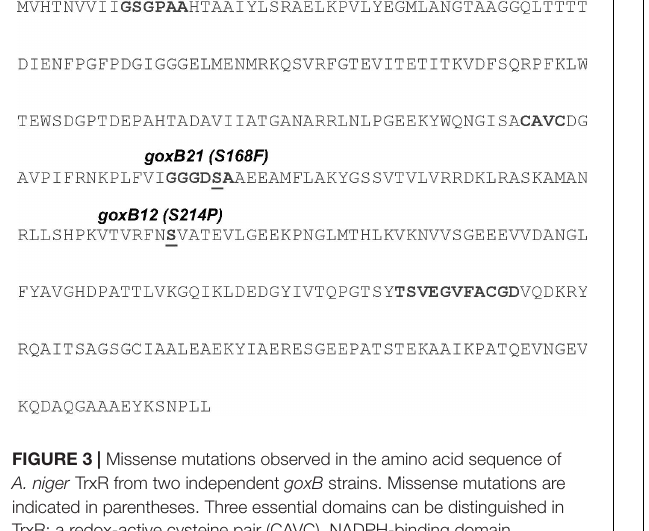
FIGURE 3 | Missense mutations observed in the amino acid sequence of A. niger TrxR from two independent goxB strains. Missense mutations are indicated in parentheses. Three essential domains can be distinguished in TrxR: a redox-active cysteine pair (CAVC), NADPH-binding domain (GGGDSA), and the FAD-binding domain (GSGPAA and TSVEGVFACGD). Induced mutations are underlined.